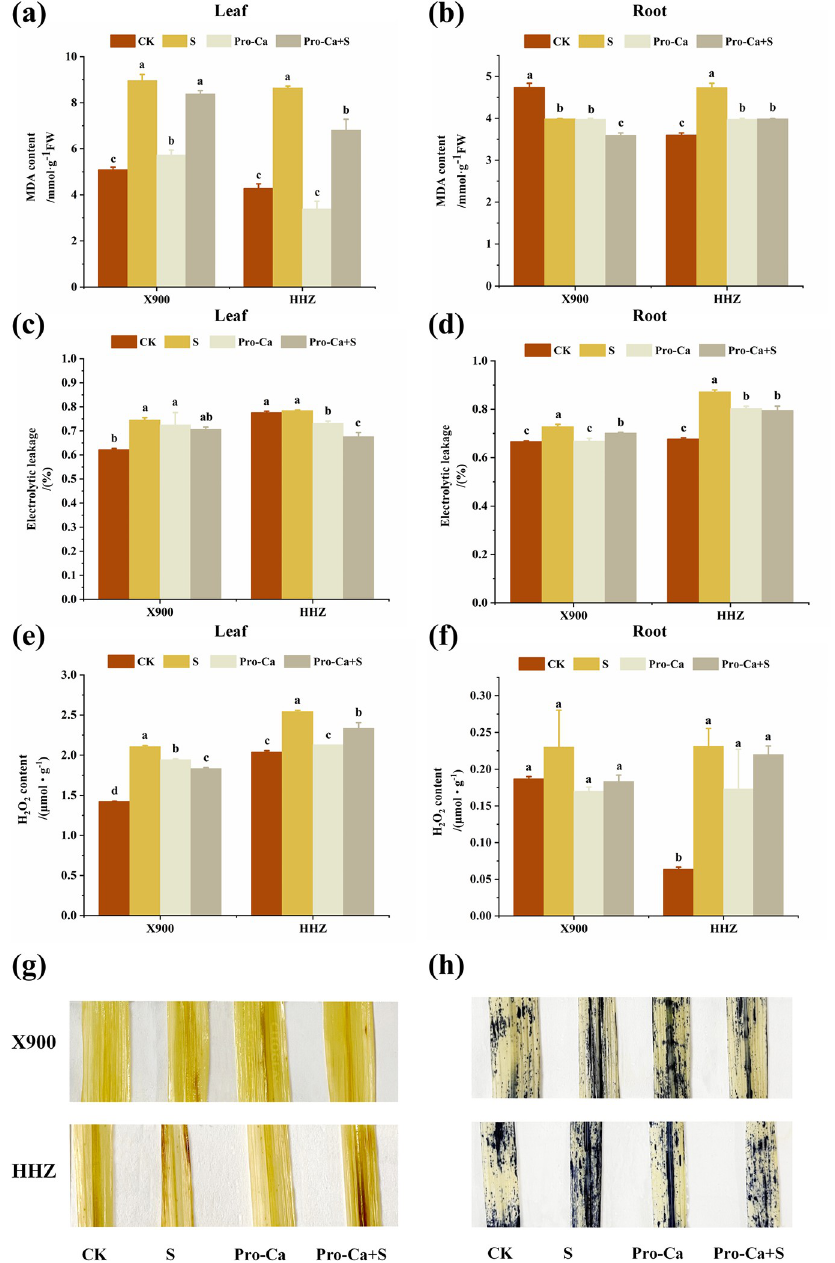
Fig 4. The alleviating effect of exogenous prohexadione-calcium (Pro-Ca) on the membrane damage and ROS accumulation of rice under salt stress. Malondialdehyde (MDA) content in the X900 (left) and HHZ (right) leaves (a) and roots (b), The electrolyte leakage (EL) in the X900 (left) and HHZ (right) leaves (c) and roots (d), The H 2 O 2 content in the X900 (left) and HHZ (right) leaves (e) and roots (f), The H 2 O 2 accumulation in the X900 and HHZ leaves (g) was determined by DBA staining, and the O 2 � − production rate in the X900 and HHZ leaves (h) was determined by NBT staining. Abbreviations: CK (water spraying + 0% NaCl), S (water spraying + 0.3% NaCl), Pro-Ca (100 mg � L -1 Pro-Ca leaf spraying + 0.3% NaCl), and Pro-Ca+S (100 mg � L -1 Pro-Ca leaf spraying + 0.3% NaCl). The numerical value represents the mean ± SE ( n = 3), and different lowercase letters indicate significant differences according to Duncan’s test ( p <